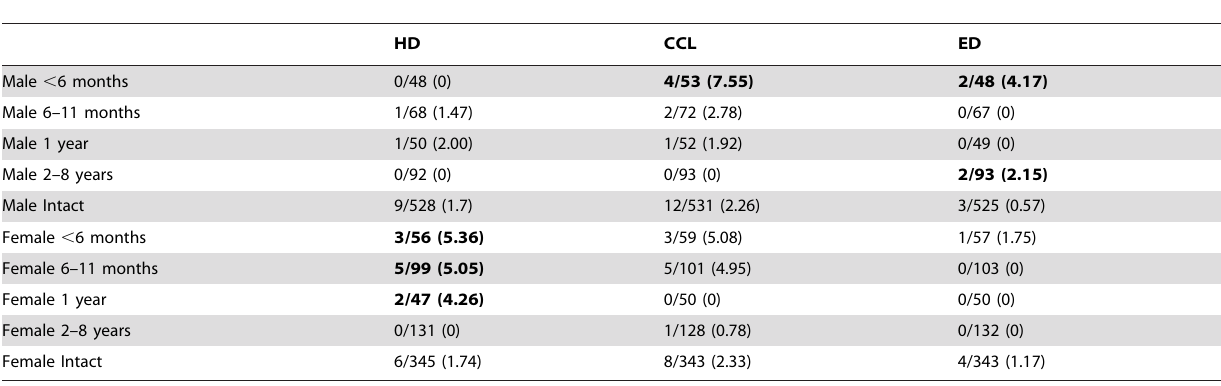
Table 4. Labrador Retriever males and females, joint disorders.